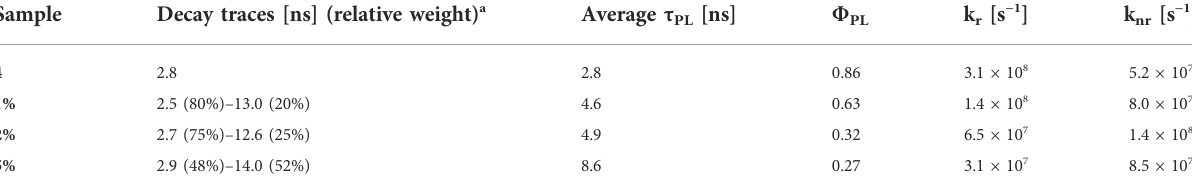
TABLE 2 Excited-state lifetimes, fl uorescence quantum yields, radiative rate constants (k r ) and non-radiative rate constants (k nr ) of the BOPHY2- PMOs. Sample Decay traces [ns] (relative weight) a